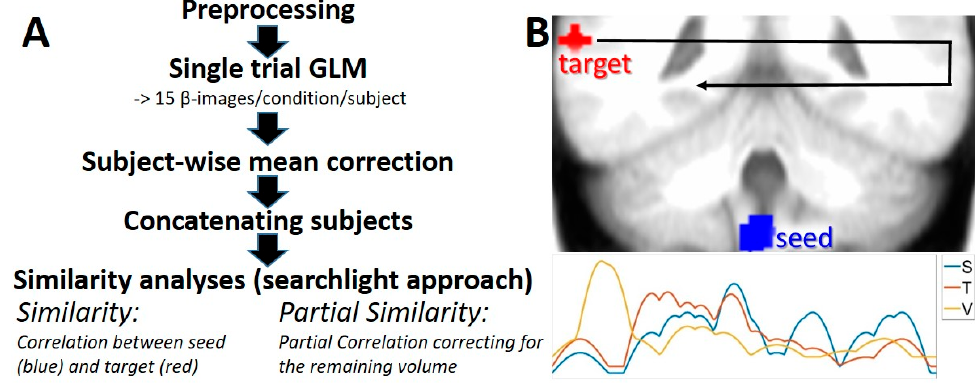
Figure 1. Sketch of the analyzing path used for the current study. ( A ) Similarity and Partial Similarity use concatenated trial-by-trial beta-images from the GLM analyses. ( B ) The searchlight approach used for the analysis involves the STN as seed (S, blue) whereas the target (T, red) represents a sphere wandering (represented by the black arrow) through the volume in a searchlight approach. Any signal that is detected in all volumes (such as movement artefacts) is used for correction in the Partial Similarity analysis. The plot bottom right shows three possible time courses for seed, target and general signal shared by the whole volume (V).